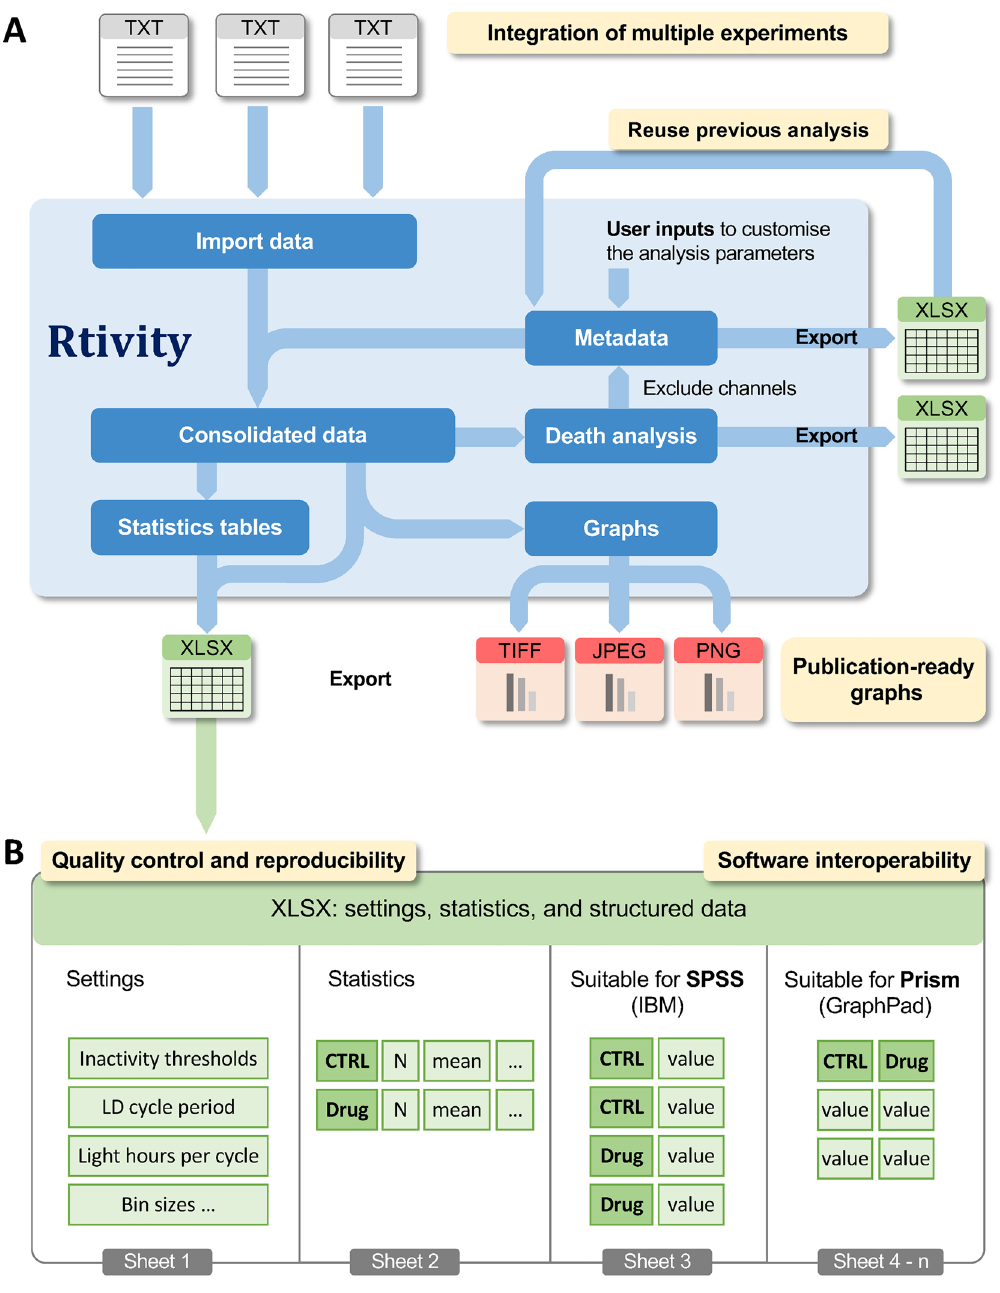
Figure 4. Software workflow and interoperability. ( A) Rtivity can integrate multiple monitor files in the same analysis. From these files, users select conditions to analyse and input analysis parameters that become exportable metadata (XLSX), which can be reused to repeat/continue the analysis. Metadata contain: filename, start and finish dates, channels, labels (condition name), order (used to order the conditions in the graphs), and light-onset time (ZT0). Rtivity allows death analysis and exports (XLSX) the associated settings and results (survival status and time of death or last activity timepoint of all channels). Rtivity represents behavioural parameters in graphs and computes the statistics associated with each representation. Graphs can be customised for publication and exported in a user-selected format. ( B) For quality control and reproducibility, Rtvity exports the settings associated with each analysis. For interoperability, Rtivity exports consolidated data, providing two common structures required by main statistical software (conditions in column vs. row). Figure was drawn by co-authors RS and JMAO using version 2.8.22 of the free image editor GIMP (https:// www. gimp.